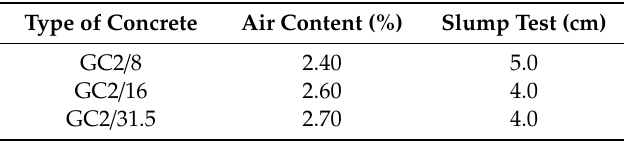
Table 5. Properties of gravel concrete.